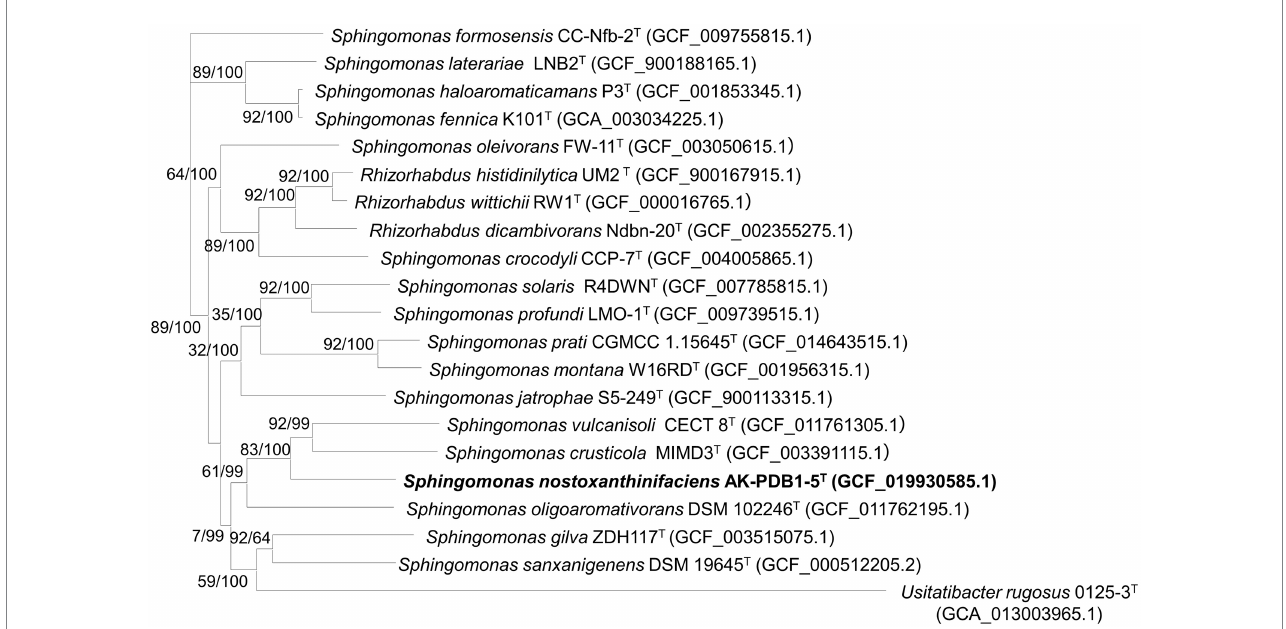
FIGURE 2 Maximum-likelihood (ML) algorithm phylogenomic tree based on up-to-date bacterial core genes (UBCGs; concatenated alignment of 92 core genes) showing the relationship between strain AK-PDB1-5 T and other members of the genus Sphingomonas . Gene support index (GSI, left) and bootstrap values (right) are indicated at the nodes. Scale bar, 0.050 substitutions per position. The 92 bacterial core genes were alaS, argS, aspS, cgtA, coaE, cysS, dnaA, dnaG, dnaX, engA, ffh, fmt, frr, ftsY, gmk, hisS, ileS, infB, infC, ksgA, lepA, leuS, ligA, nusA, nusG, pgk, pheS, pheT, prfA, pyrG, recA, rbfA, rnc, rplA, rplB, rplC, rplD, rplE, rplF, rplI, rplJ, rplK, rplL, rplM, rplN, rplO, rplP, rplQ, rplR, rplS, rplT, rplU, rplV, rplW, rplX, rpmA, rpmC, rpmI, rpoA, rpoB, rpoC, rpsB, rpsC, rpsD, rpsE, rpsF, rpsG, rpsH, rpsI, rpsJ, rpsK, rpsL, rpsM, rpsO, rpsP, rpsQ, rpsR, rpsS, rpsT, secA, secG, secY, serS, smpB, tig, tilS, truB, tsaD, tsf, uvrB, ybeY, and ychF.